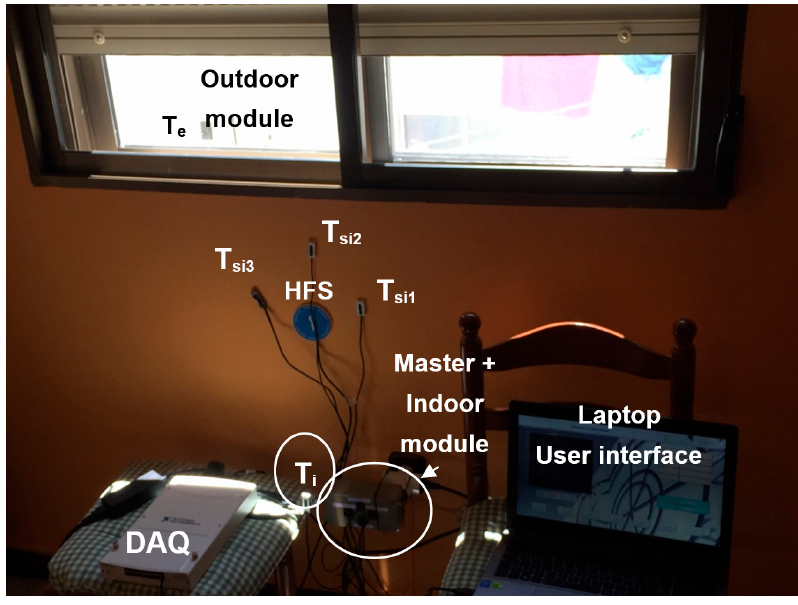
Figure 9. U-Value measurement experimentation assembly.